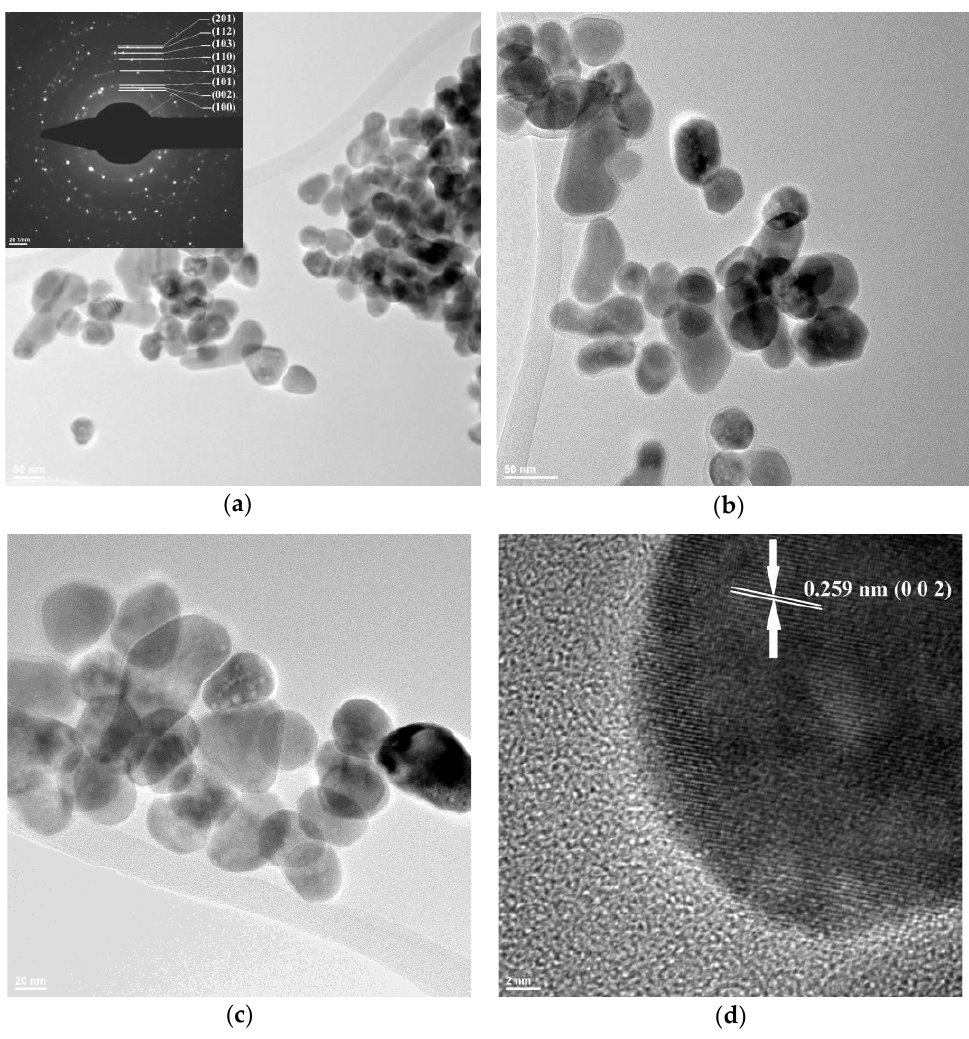
Figure 4. The TEM images for ZnO_EG samples ( a ) 29,500× magnification and SAED pattern of hex- agonal ZnO (JCPDS card no. 80-0075) in inset; ( b ) 49,000× magnification; ( c ) 75,000× magnification; ( d ) high resolution TEM with (0 0 2) crystallographic planes.